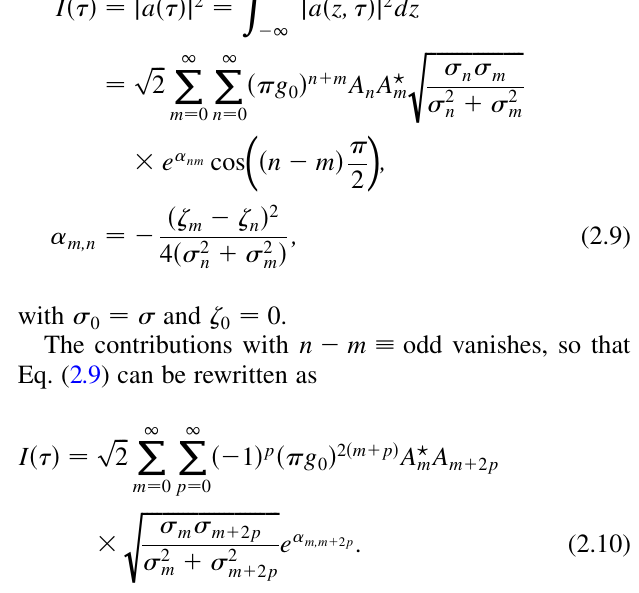
ffiffiffiffiffiffiffiffiffiffiffiffiffiffiffiffiffiffiffi